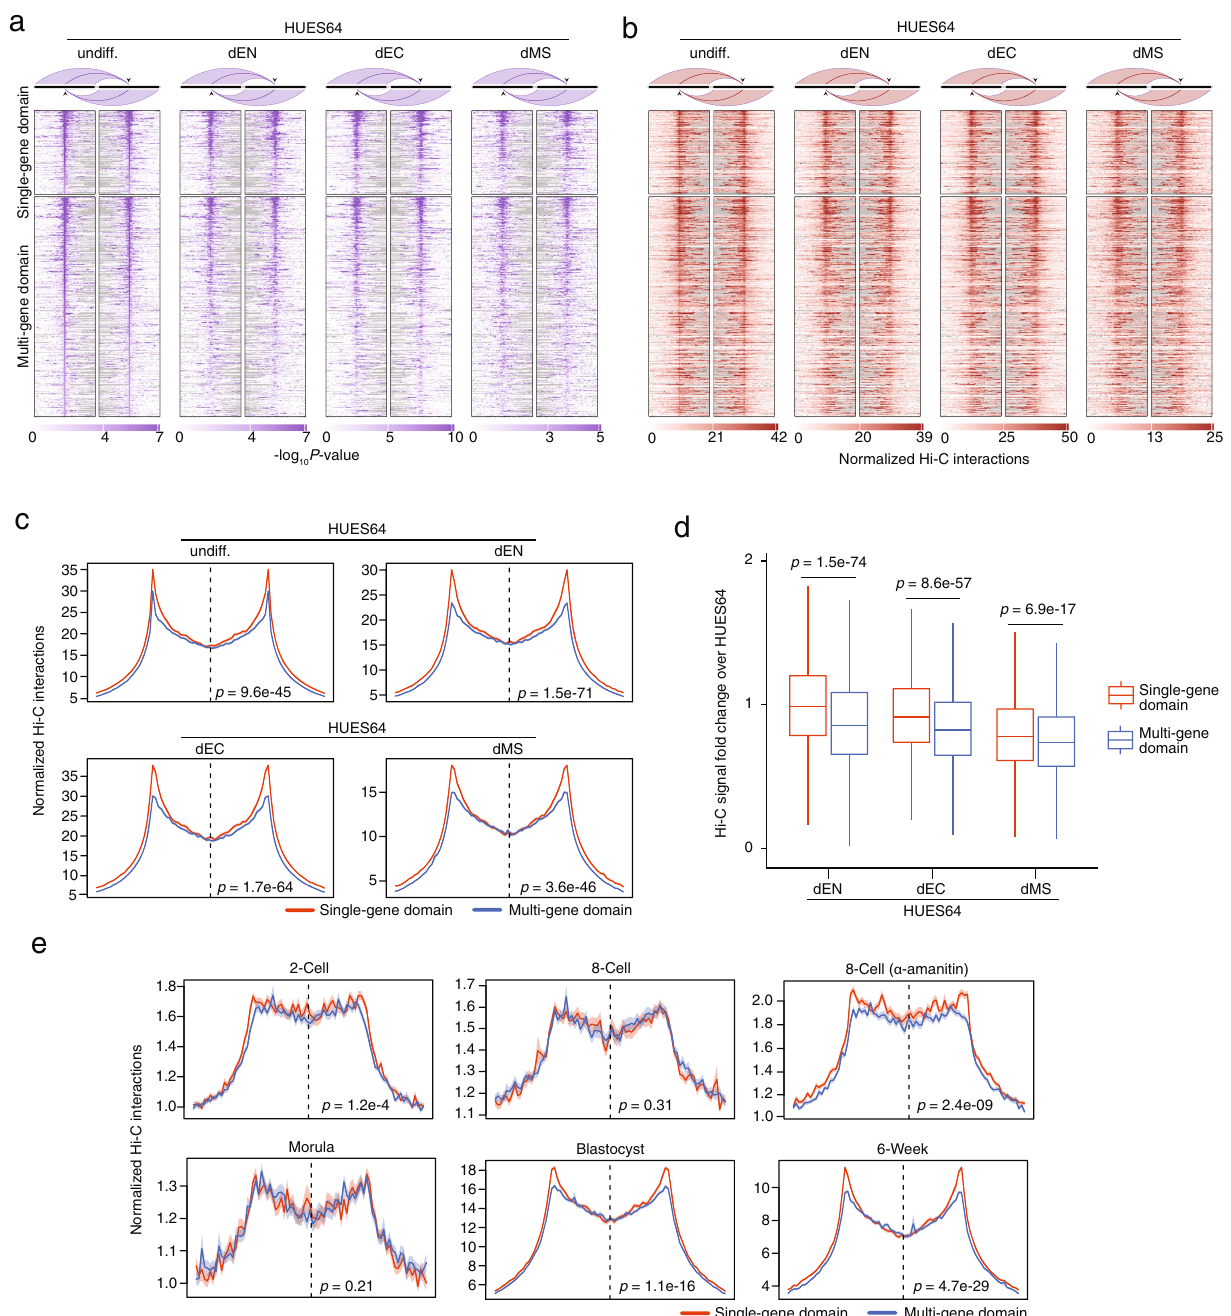
corresponding boundary interaction loss (Boundary 2) along with an increased interaction speci fi cally in de fi nitive endoderm at the upstream boundary (Boundary 1) in one of the boundary deletion cell lines (SOX17 Δ 5 ’ CTCF#8.2 ) (Fig. 4d, e, Supplementary Fig. 5a, b and Supplementary Data 3). We also identi fi ed a signi fi cant reduction of intraloop domain contacts ( SOX17 loop domain, SOX17 upstream loop domain) in SOX17 Δ 5 ’ CTCF#8.2 iPSCs as well as a reduction of endoderm-speci fi c enhancer contacts between the SOX17 promoter and its most distal regulatory element DRE (A)) (Fig. 4d, e and Supplementary Fig. 6b, c). In concordance with highest intergroup contact correlations (Supplementary Fig. 6d) and without any further evidence of ectopic enhancer adoption or alternative